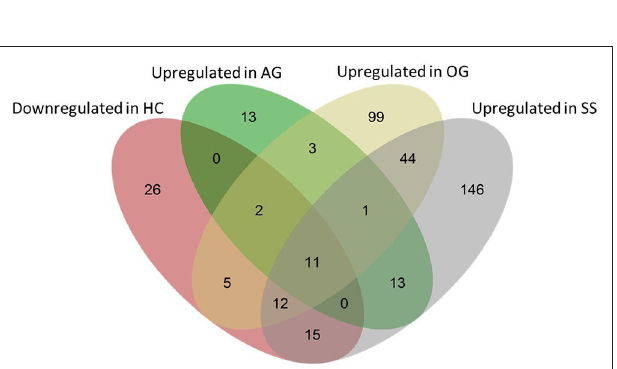
FIGURE 8 | Venn diagram showing the total number of genes that were affected by the experimental diets. The pink ellipse includes the genes that were downregulated in the HC group compared to the CT group. Green, yellow and gray ellipses include genes that were upregulated (compared to the HC group) in the AG, OG and SS groups, respectively. Thirteen (2 + 11), 30 (2 + 5 + 11 + 12) and 38 genes (12 + 15 + 11) that were downregulated in the HC group were upregulated in the AG, OG and SS groups,